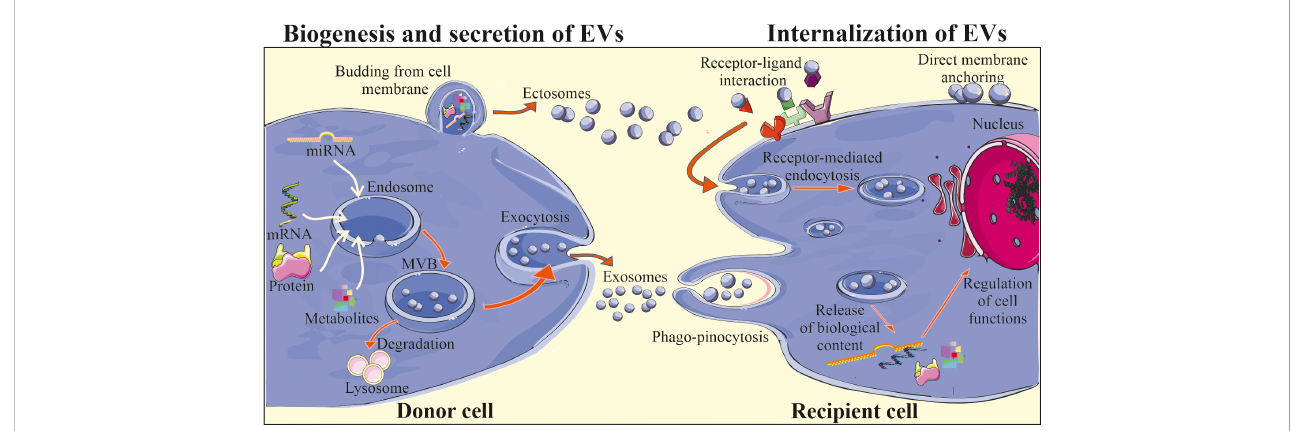
FIGURE 1 Biogenesis and biological activity of EVs. Two main subtypes of EVs are exosomes and ectosomes (microvesicles) that differ in terms of their biogenesis and secretion. Exosomes are initially formed in MVBs located in the cytoplasm, with the involvement of endosomal pathway and intracellular traf fi cking of MVBs, that may be either degraded in the lysosomes or may fuse with the plasma membrane, releasing exosomes into the extracellular milieu. Ectosomes are considered to be generally larger than exosomes and are formed through the outward plasma membrane budding and shedding. After release EVs may interact with the recipient cells, delivering their cargo via direct fusion with cell membrane, endocytosis, receptor-ligand interaction or phago/pinocytosis. Consequently, internalization of EV content may lead to the changes in the biological activity of the target